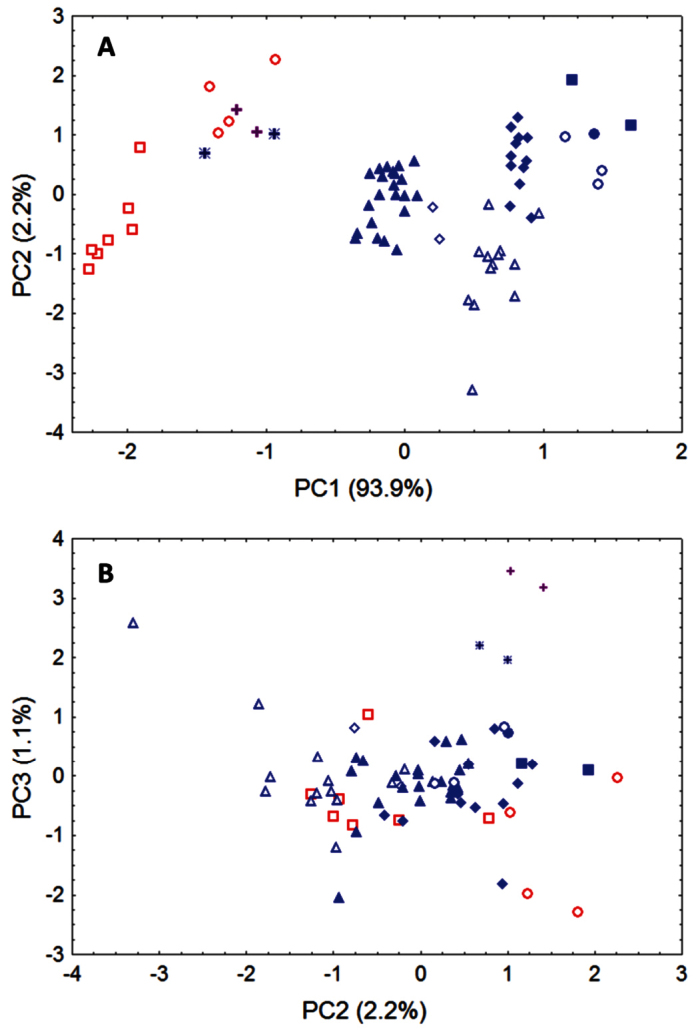
Morphometric separation (first three principal components of a Principal Components Analysis) of 12 cranial and dental measurements. Data are from 70 adult skulls of Glauconycteris, Niumbaha, and Scotophilus (with measurements following Table 1 and 2). Specimens of Scotophilus, included for ecomorphological comparison, are indicated in red (open red squares, Scotophilus leucogaster; open red circles, Scotophilus viridis). Specimens of Glauconycteris are indicated in blue (open blue diamonds, Glauconycteris alboguttata; open blue triangles, Glauconycteris argentata; open blue circles, Glauconycteris beatrix, closed blue circles, Glauconycteris curryae; closed blue squares, Glauconycteris humeralis; closed blue diamonds, Glauconycteris poensis; closed blue triangles, Glauconycteris variegata). Specimens of Niumbaha superba from central Africa (DRC, S Sudan) are marked with crosses; specimens of Niumbaha superba from west Africa (Cote D’Ivoire, Ghana) are marked with asterisks. A Skulls of Niumbaha separate from skulls of species of Glauconycteris in combination along the first and second components, suggesting greater overall ecomorphological resemblance of Niumbaha with medium-sized, less specialized African vespertilionids such as Scotophilus. The first principal component reflects distinctions in overall skull size, which increases from right to left. B Separation of skulls of Niumbaha from those of Glauconycteris and Scotophilus in combination along the second and third components indicates the morphological isolation of Niumbaha and illustrates consistent differences in skull shape, reflecting (in separation along the third component) the proportionally narrower interorbital dimensions, less dramatic postorbital constriction, longer toothrows, narrowed skull, but widened anterior rostrum in Niumbaha relative to Glauconycteris.